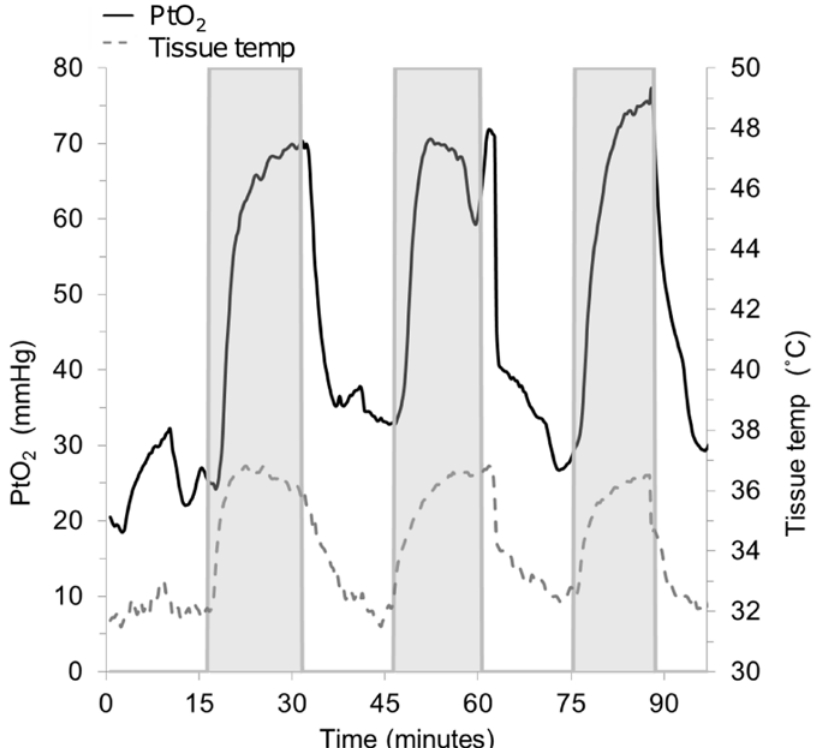
Fig 1. Representative data from one rat in experiment 1 (Insufflation of humidified-warm CO 2 vs exposure to ambient air). The shaded areas show each period of insufflation of humidified-warm CO 2 . A rapid increase in both PtO 2 and tissue temperature is seen each time gas insufflation is started, and is reversed when insufflation is stopped.